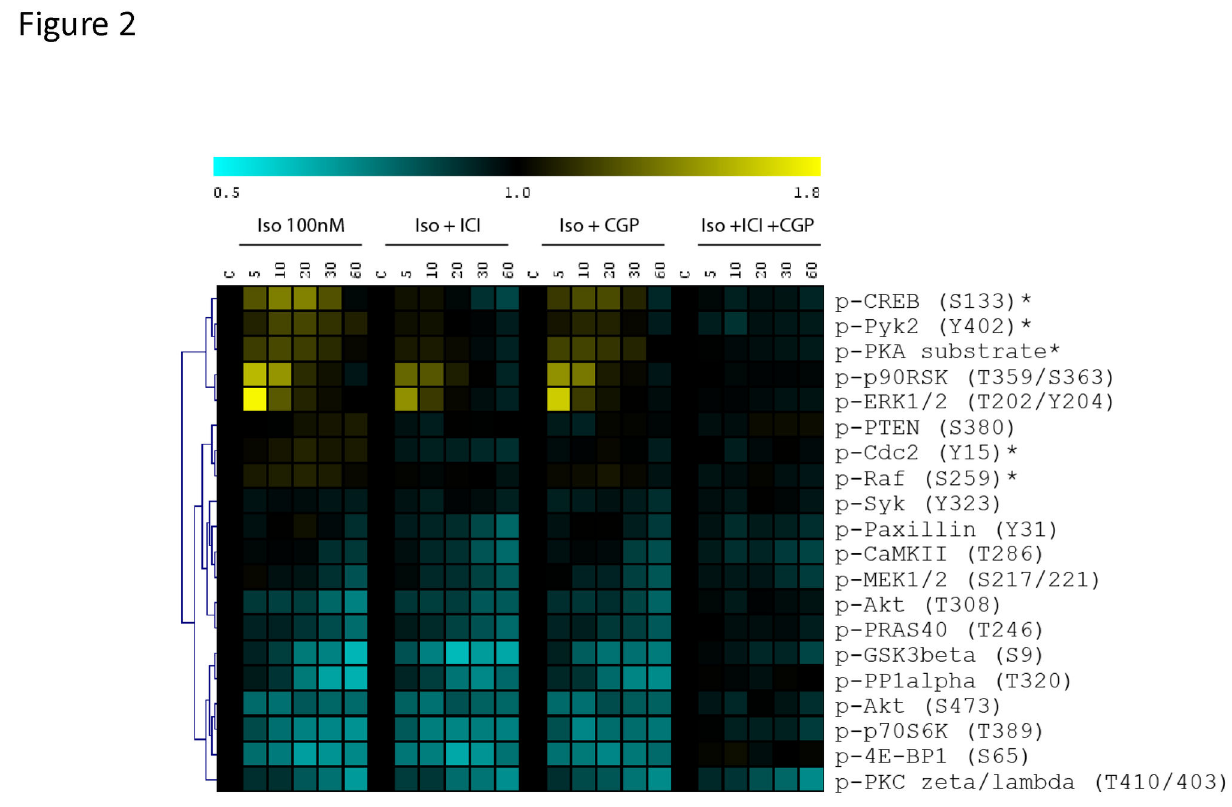
Figure 2. Isoproterenol induced phosphoprotein signaling in the presence of selective β-AR antagonists. MEFs were pretreated with the β1-AR antagonist CGP 20712A (CGP) and β2-AR antagonist ICI 118,551 (ICI) prior to stimulation with isoproterenol. CGP and ICI were used at final concentrations of 10 μM. MEFs were then stimulated with isoproterenol (Iso) (100 nM) for various times (0, 5, 10, 20, 30, or 60 minutes). The heat map shows phosphorylation (yellow) and dephosphorylation (blue) events after isoproterenol stimulation. The color scale shows fold change as compared with unstimulated MEFs. Data are means of three independent stimulation experiments. * denotes pathways with reduced phosphorylation in the presence of ICI 118,551 as determined using the SAM algorithm (q value <